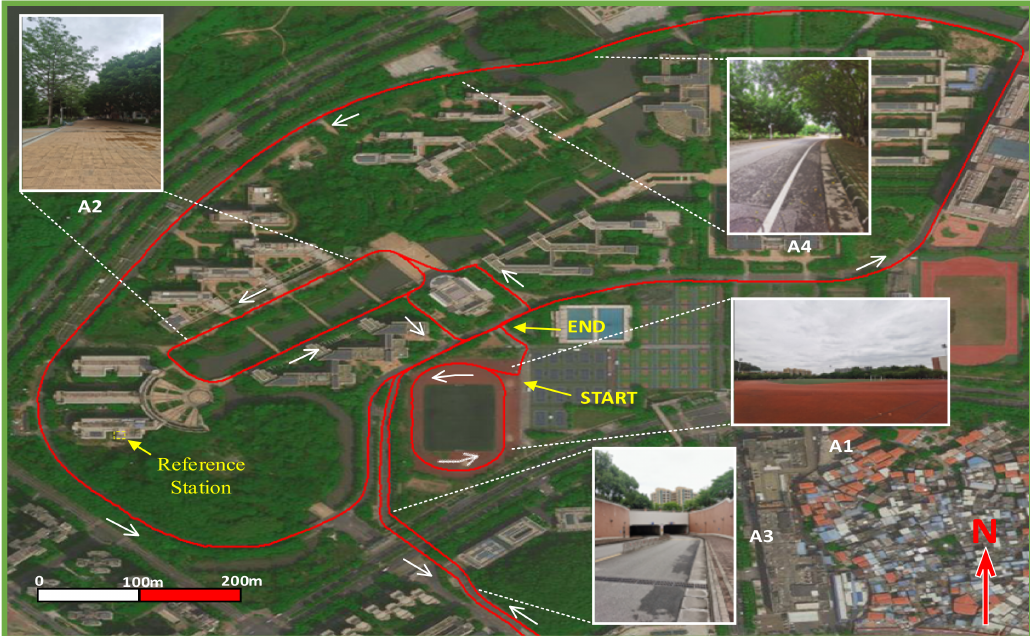
Figure 2. Dynamic trajectories of the whole experiments. The pictures named A1, A2, A3, and A4 show some realistic GNSS-degraded environments for each experiment, and the yellow box shows the location of the reference station. A denotes the